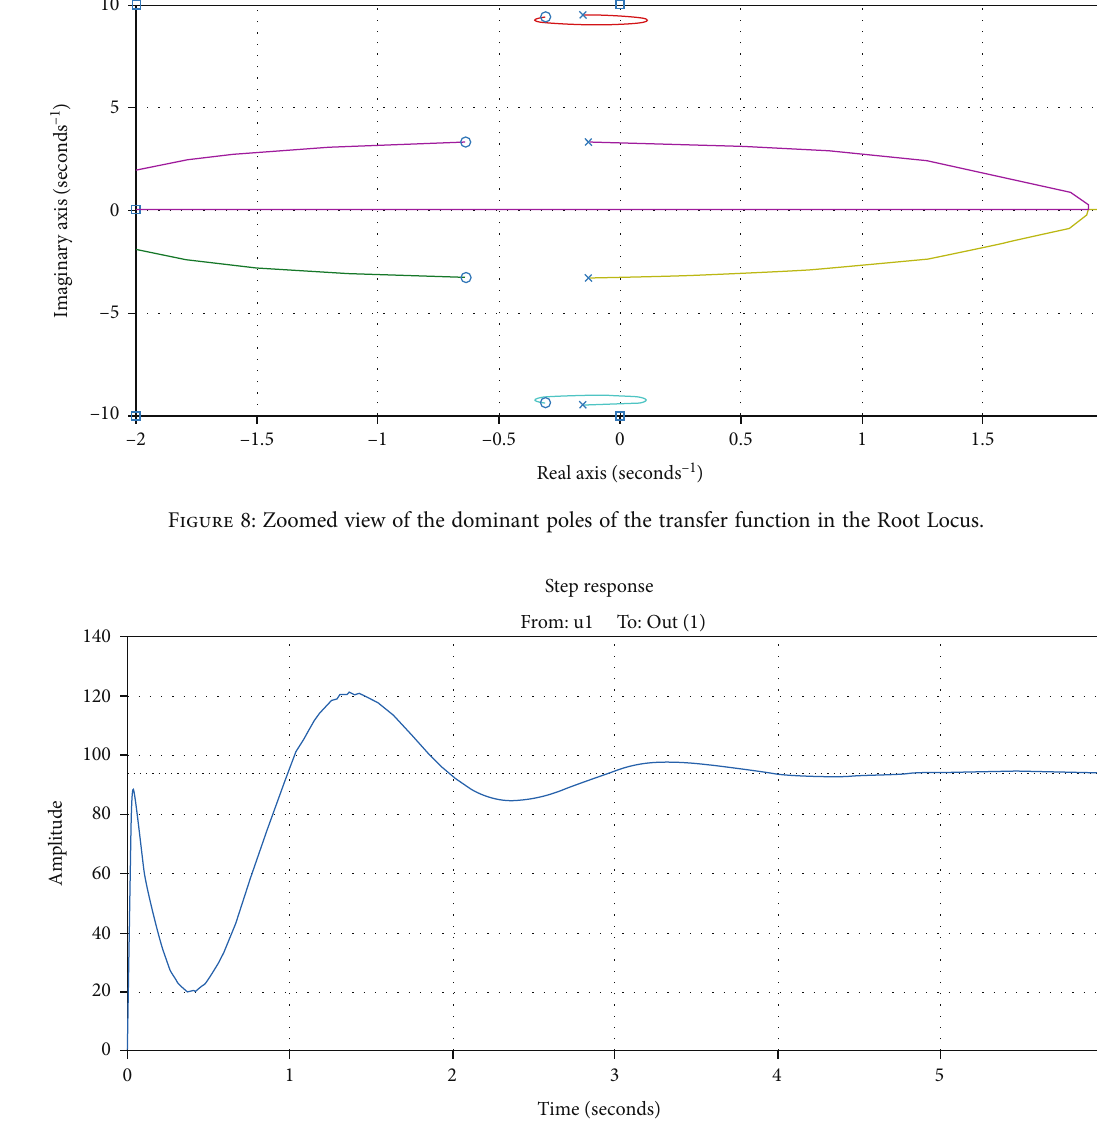
Figure 9: Step response of sys1